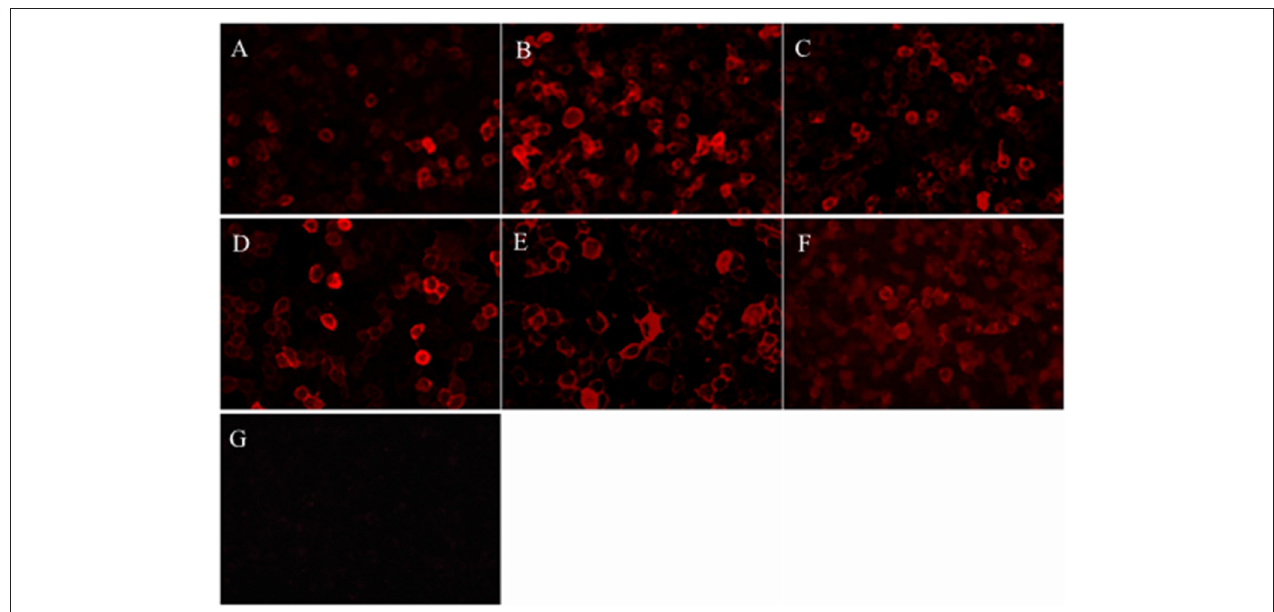
TABLE 2 | Treatment and follow-up of patients with positive anti-CASPR2 antibody. No. Therapy Final follow-up, months mRS score at follow-up